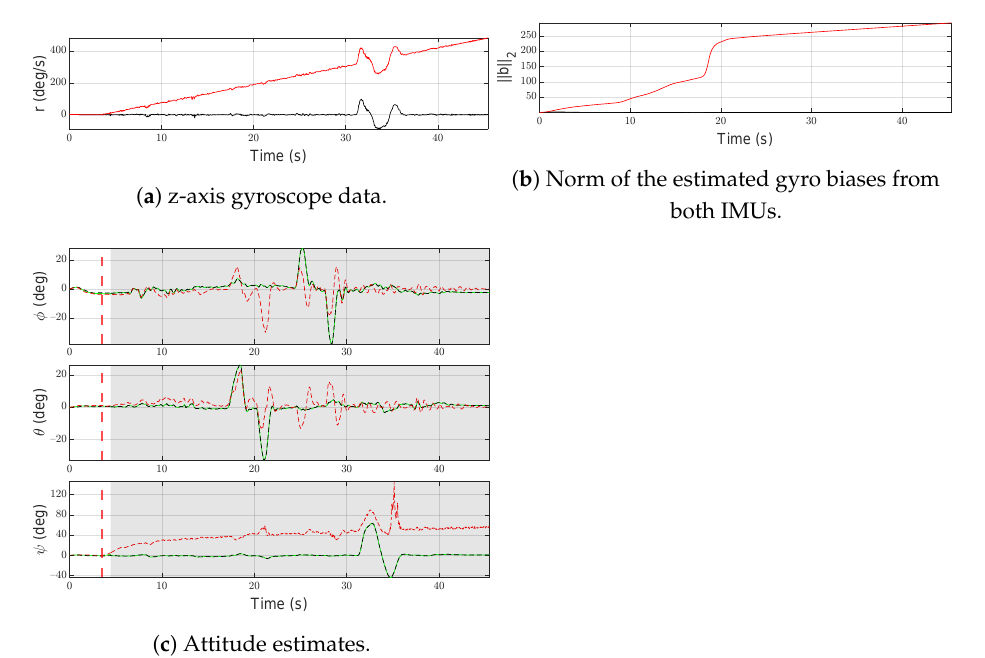
( c ) Attitude estimates. Figure 8. Scenario F2. Black lines denote measurements/estimates from IMU-1, red lines are for measurements/estimates from IMU-2. Green lines represent the output of the system, gray areas highlight the time interval in which the SFDI algorithm is in the fault state. Vertical red dashed lines denote the time instants when the fault occurs and ends.